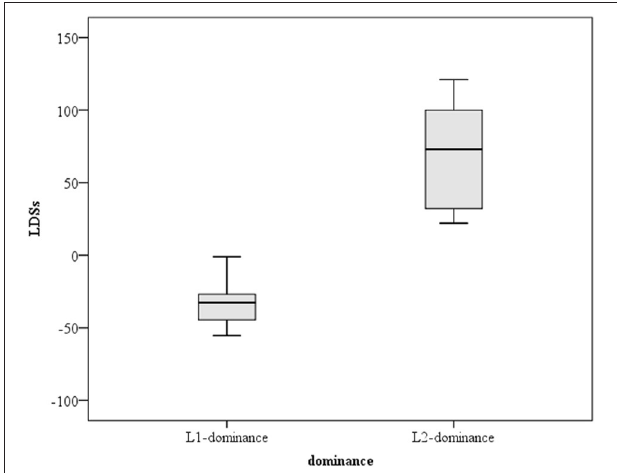
FIGURE 1 | The distribution of language dominance scores according to the Bilingual Language Profile.